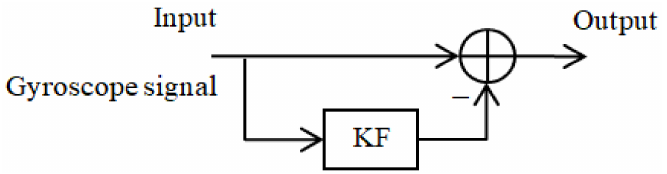
Figure 4. Structure of the Kalman filter algorithm for drift/offset